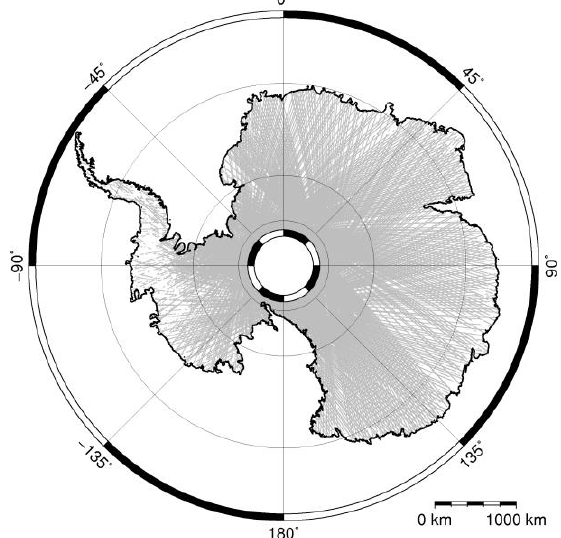
Figure 1. ICESat ground tracks on Antarctic ice sheet after filtering and corrections